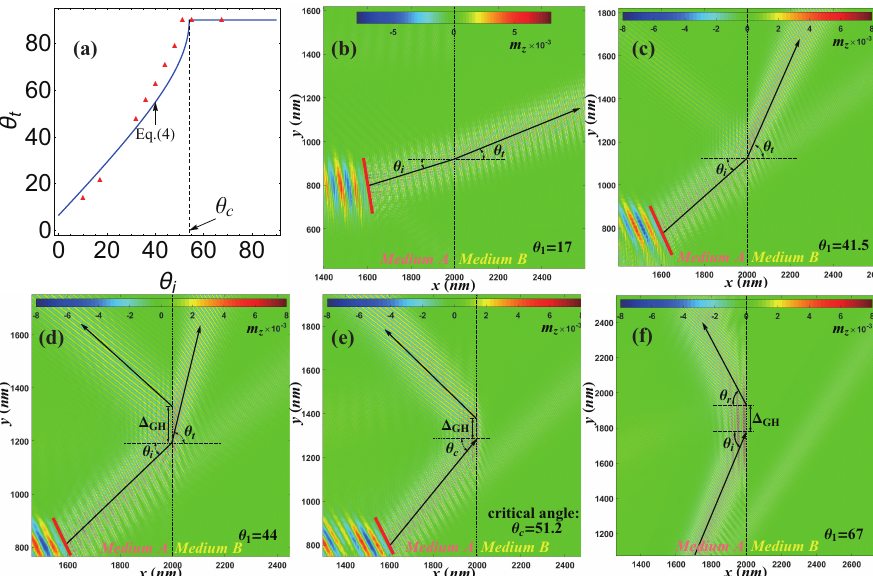
Figure 3. ( a ) The refracted angle as a function of the incident angle. Vertical dashed and solid lines correspond to the critical angle θ c . ( b – f ) The micromagnetic simulations results for spin-wave beam reflection and refraction under different incident angles ( b ) θ i = 17 ◦ , ( c ) θ i = 41.5 ◦ , ( d ) θ i = 44 ◦ , ( e ) θ i = 51.2 ◦ and ( f ) θ i = 67 ◦ . The DMI constants in medium A and B are D 1 = 4 × 10 − 3 J/m 2 and D 2 = 3.5 × 10 − 3 J/m 2 , respectively. The color map shows the z component of the magnetization in the snapshot of micromagnetic simulations at some selected time. The black solid lines correspond to the rays of the incident and refractive beams. The red rectangular area is the excitation area of the spin-wave, and the exciting field frequency is f = 100